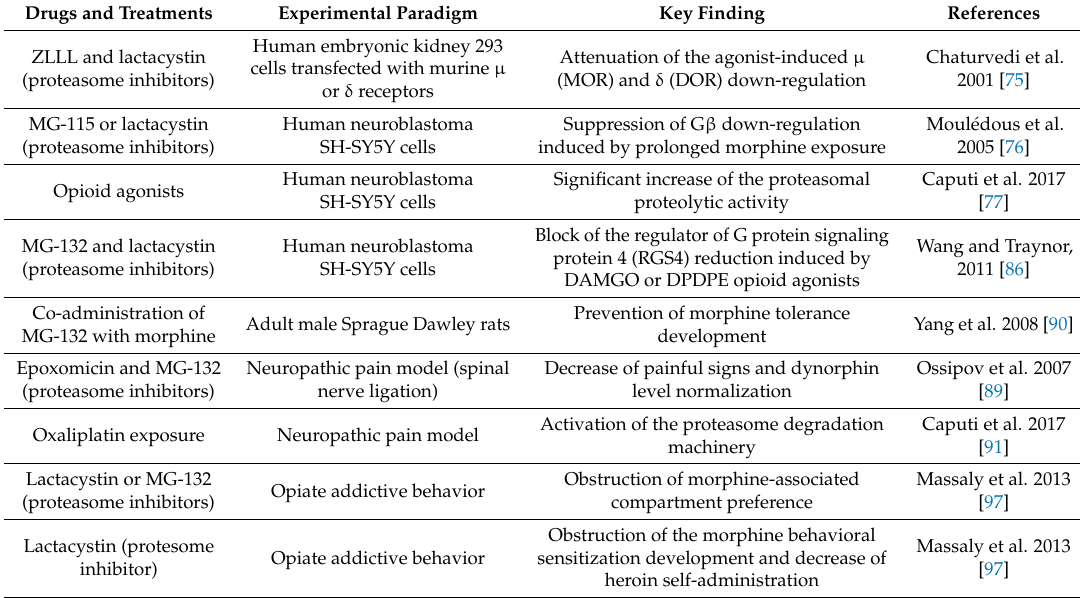
Table 1. Proteasome involvement in analgesia, neuropathic pain, and addictive behavior. Drugs and Treatments Experimental Paradigm Key